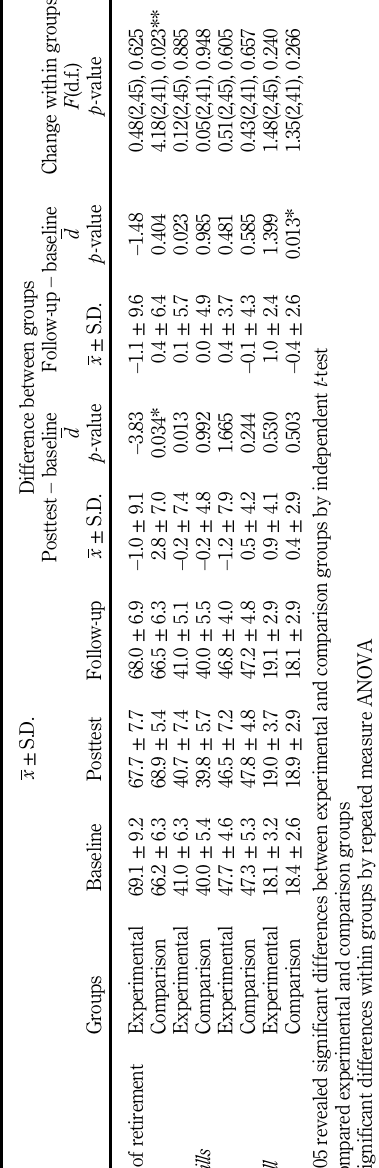
afterretirementandlife skills improvement of HRP evaluation (experimental